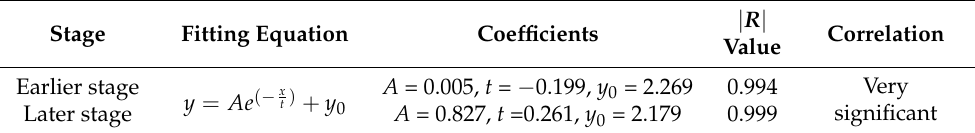
Table 5. Fitting equation and significance test of the relationship between image features after rust removal (fractal dimension) and corrosion